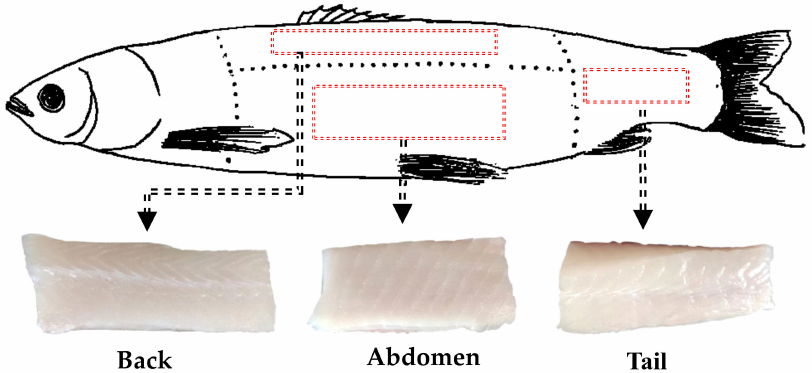
Figure 2. Schematic diagram of the collection of meat (red area) of different parts of grass